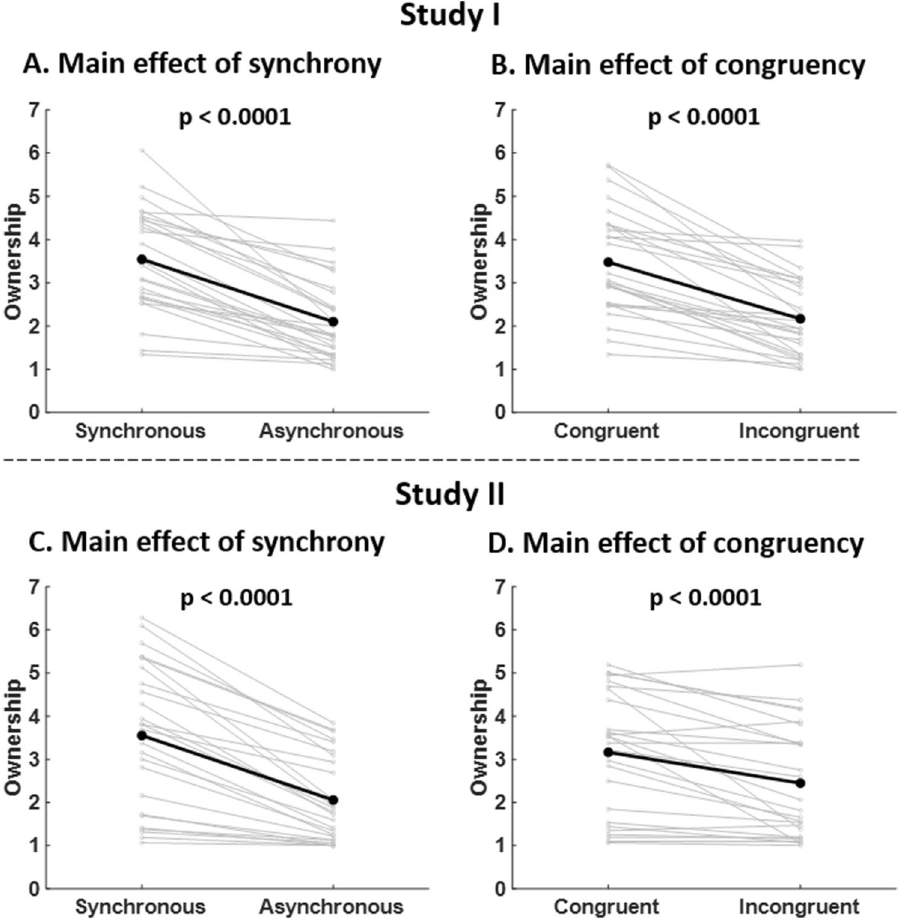
Figure 2. SO ratings (Studies I and II). ( A – C ) SO ratings for synchronous and asynchronous conditions are shown for Studies I and II. ( B–D ) SO ratings for congruent and incongruent conditions are shown for Studies I and II. For each panel, data plotted in grey represent the mean rating for individual subjects and data plotted in black represents the mean rating across subjects. The p-values correspond to the main effects reported in Table 1.